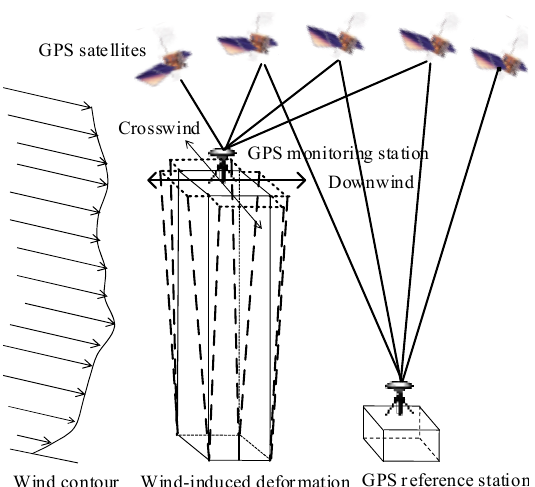
Figure 1. Scheme of monitoring wind-induced response of a tall building using GPS.